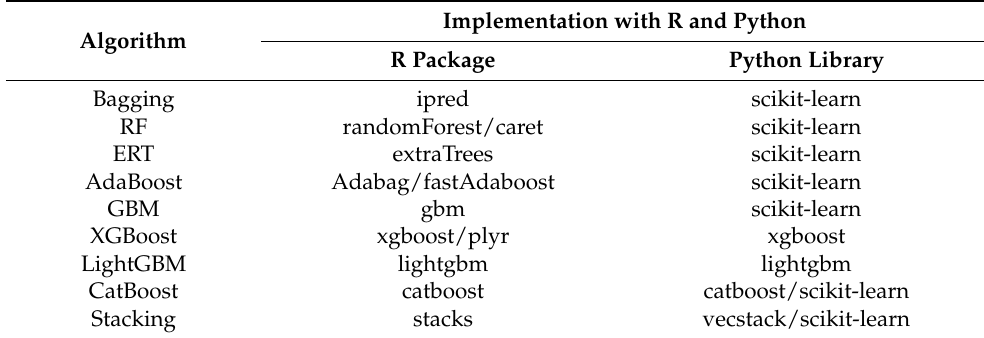
Table 1. Implementation of ensemble learning algorithms using R and Python. Implementation with R and Python Algorithm R Package Python Library Bagging ipred scikit-learn RF randomForest/caret